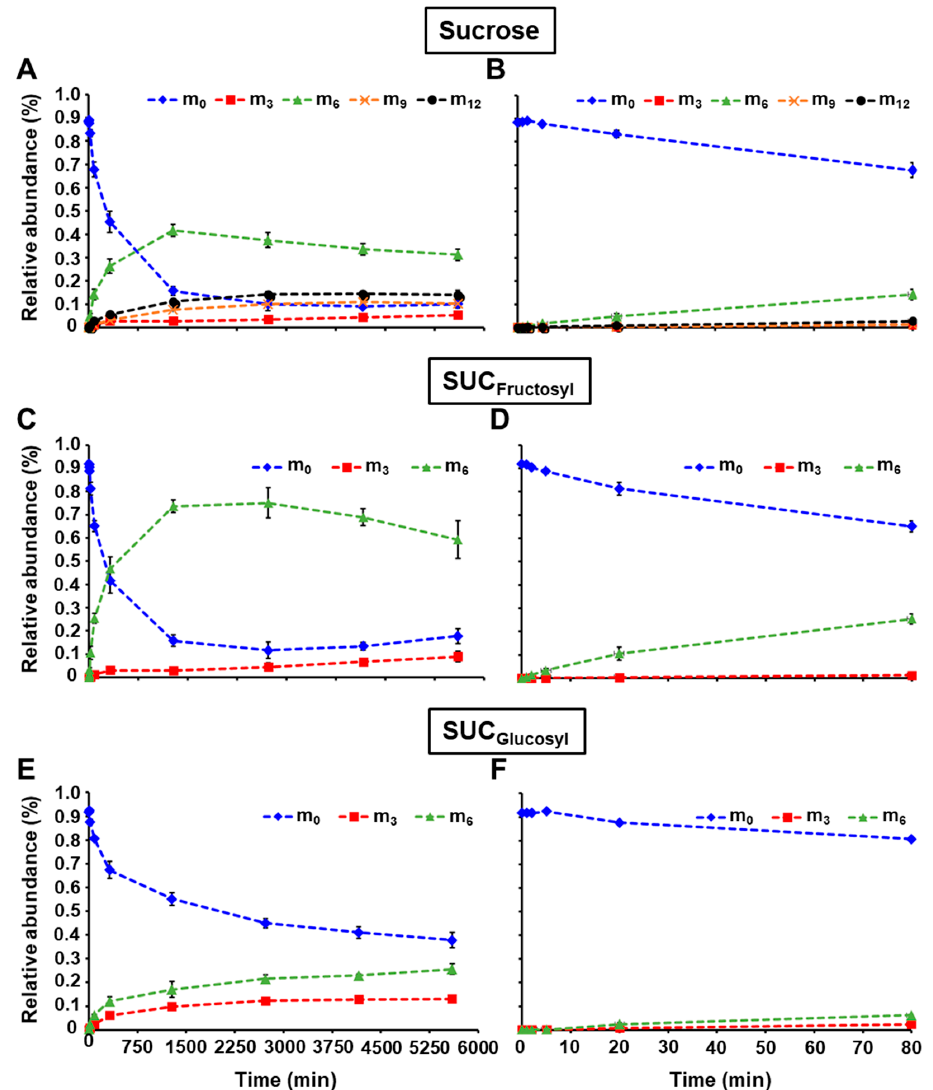
Figure 4. Relative abundance of isotopomers for 13 C-fructosyl and 13 C-glucosyl units from sucrose during the pulse labeling experiment. ( A , C , E ) represent the relative abundance of mass isotopomers at all time points for sucrose, SUC Fructosyl , and SUC Glucosyl , respectively. ( B , D , F ) depict the relative abundance of mass isotopomers from 0 to 80 min for sucrose, SUC Fructosyl , and SUC Glucosyl , respectively. Sucrose was extracted, cleaved into its fructosyl and glucosyl units, and analyzed as described in the Materials and Methods section. Mass relative abundances (in %) were reported as the average ± SD (n = 4 biological replicates). Mass isotopomers m 0 , m 3 , m 6 , m 9 , m 12 are shown as blue diamond, red square, green triangle, orange cross, and black circle, respectively. SUC Fructosyl : Sucrose fructosyl; SUC Glucosyl : Sucrose glucosyl.